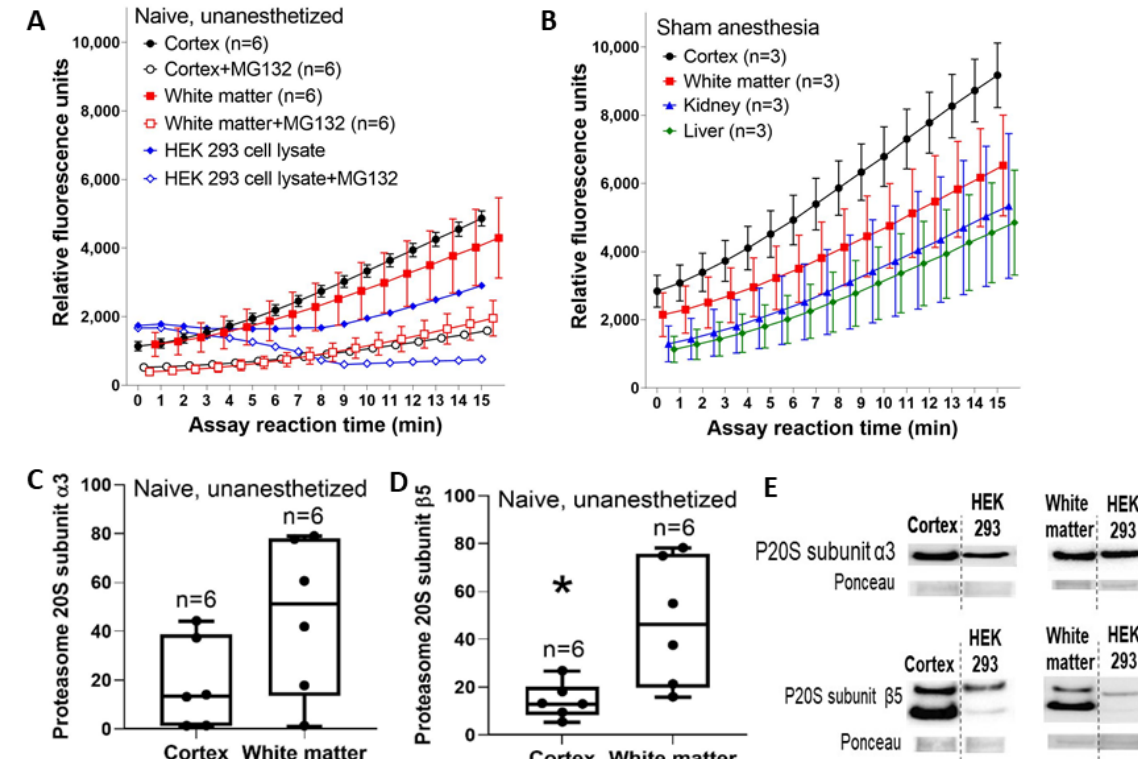
Figure 2. Reaction progress curves for proteasome activity in somatosensory cortex and subcortical white matter of uninjured neonatal piglets. ( A ) The proteasome inhibitor MG132 reduced fluorescence in the cortex and white matter independently ( p = 0.005) and interactively with assay time ( p < 0.001). In post-hoc comparisons, MG132 decreased the fluorescence levels in the cortex ( p < 0.001) and white matter ( p < 0.001). Proteasome activity did not differ between the cortex and white matter in the presence or absence of MG132 ( p > 0.05 for both). An HEK293 cell lysate with and without MG132 treatment is shown for a control comparison. ( B ) Separate piglets received 3 h of normothermic sham anesthesia and 24-h recovery. The cortex had the highest proteasome activity followed by the white matter. The liver and kidney had lower activity than either brain region. Data are shown as means with standard errors of the means. ( C , D ) Western blot analysis showed that naïve cortex and white matter had similar proteasome 20S subunit α 3 levels (C, p = 0.094), but immunoreactivity for proteasome 20S subunit β 5 was higher in white matter than in the cortex (* p = 0.015). Between-gel comparisons were made by dividing each band’s immunoreactivity optical density by the density of a common HEK293 cell lysate that was loaded into every gel. In panels ( C , D ), each circle represents one piglet and the box plot whiskers are 5–95th percentiles. ( E ) Representative western blots of the naïve, unanesthetized piglet brain. Bands from the cortex and the HEK293 cell lysate are shown from the same gel with the same exposure time. Separate gels have bands from white matter and the HEK293 cell lysate. Molecular weights are indicated.